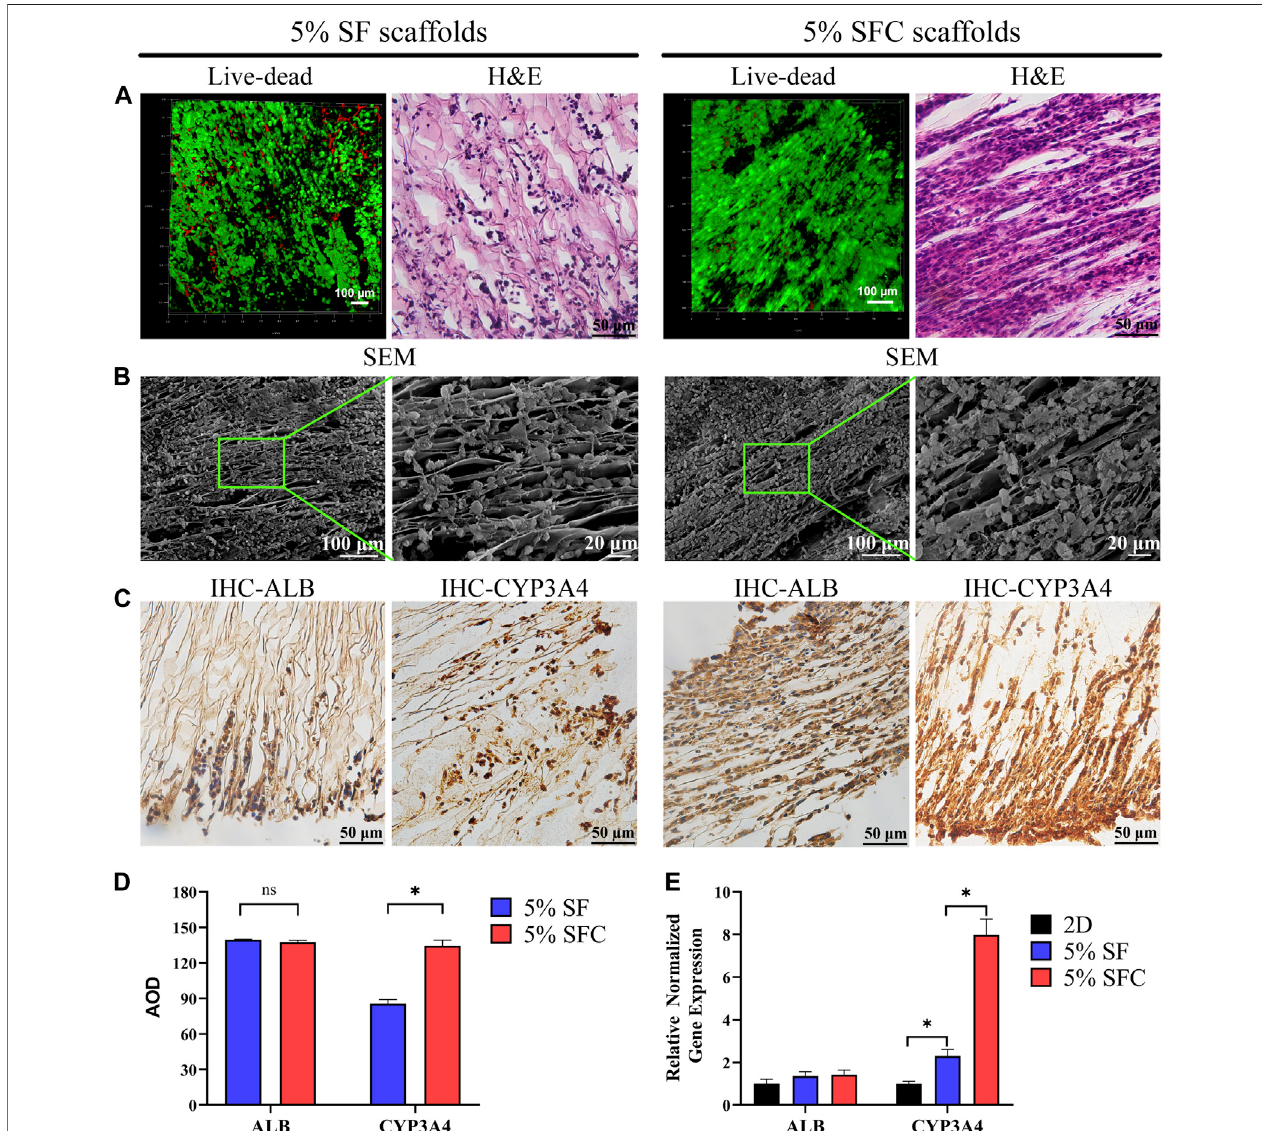
FIGURE3| Biocompatibilityof5%compositeSFCscaffolds(w/v).TheviabilitystainingandH&Estainingofcellsinbothscaffolds (A) .SEMimages (B) showingthe cellgrowthpatternonthesurfaceofbothscaffolds.IHCdetection (C) ofALBandCYP3A4expressionofC3Acellsinbothscaffolds.QuantitativeanalysisofIHCstaining (D) and functional gene expression of C3A cells in both scaffolds (E) . (* p < 0.05).